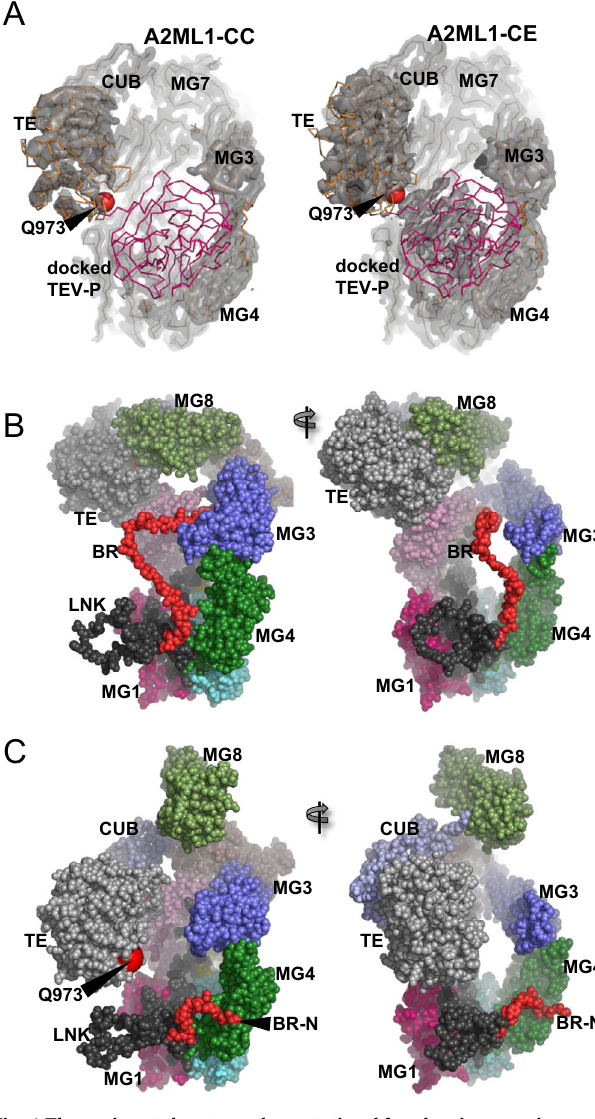
Fig. 6 The conjugated protease has rotational freedom in an environment containing fl exible extended regions. A Comparison of the EM maps for A2ML1-CC and A2ML1-CE with a docked TEV-P. The absence of EM map density close to the thioester suggests rotational freedom and multiple possible conjugation sites on the protease. Strikingly, weak density is present in the volume of the docked TEV-P in A2ML1-CE, possibly due to a few preferred conformations of the LNK region in the empty trap state. B Hypothetical full model of native A2ML1. LNK residues not modeled in any of the structures were taken from the alphafold2 prediction 57 . The bait region was modeled by hand in Coot 50 with exposure of the experimental cleavage sites presented in Fig. 1E, F. C Hypothetical full model of cleaved A2ML1. Regions in LNK and the N-terminal part of the bait region (BR-N) not modeled in A2ML1-CC were modi fi ed manually in Coot starting from their conformation in panel B